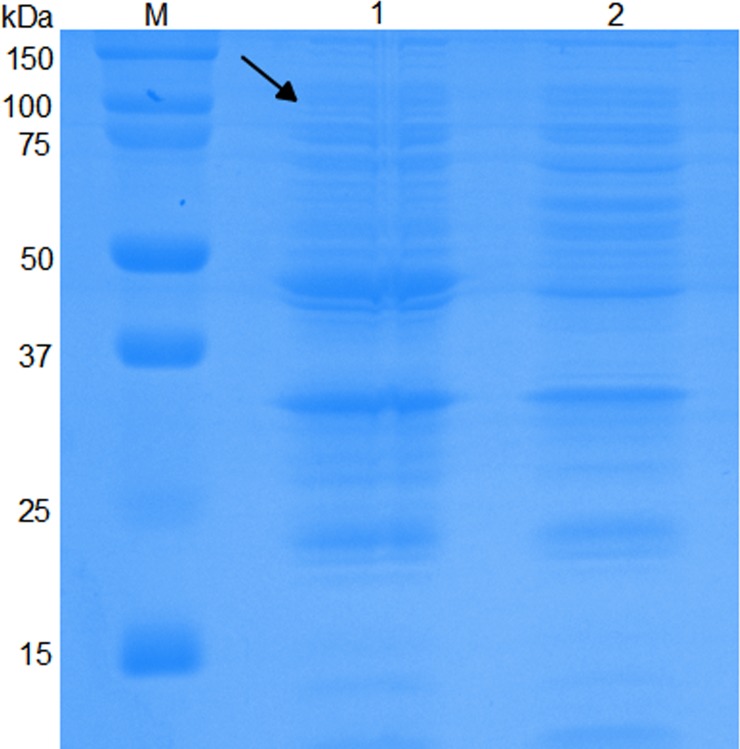
SDS-PAGE of Apxr-OMVs recombinant proteins.Lane M: protein marker. Lane 1: Apxr-OMV. Lane 2: OMV-Empty.